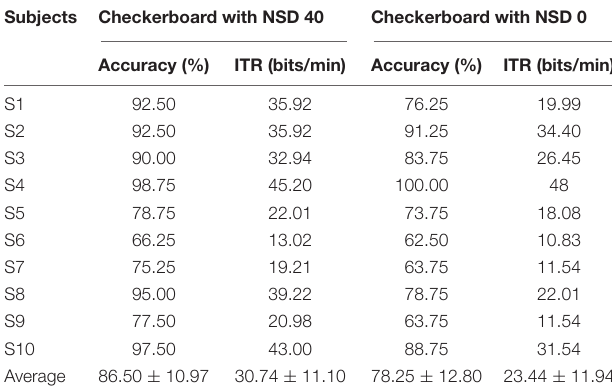
TABLE 1 | BCI performance of all subjects in the online experiment. Subjects Checkerboard with NSD 40 Checkerboard with NSD